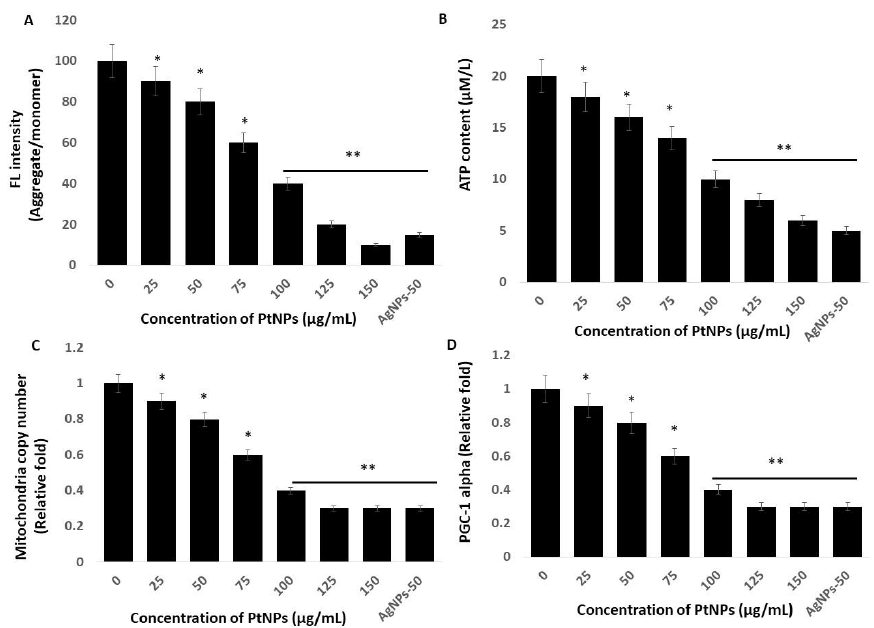
Figure 7. PtNPs decreased mitochondrial membrane potential (MMP), ATP content,